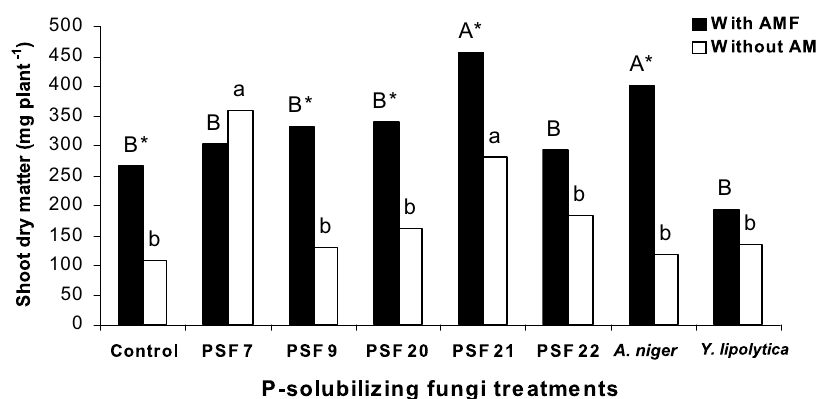
Fig. 1 – Shoot dry matter (two cuts) of clover inoculated with P-solubilizing fungi from Paraty, Rio de Janeiro, Brazil (PSF 7, 9, 20, 21 and 22) and from Granada, Spain ( A. niger and Y. lipolytica ), in the presence or absence of AMF. (Lower-case and upper-case letters compare PSF treatments in the absence and presence of AMF inoculation, respectively, by the Scott-Knott test ( p ≤ 0 . 05 ) . *: indicates AMF effect by the F test ( p ≤ 0 . 05 ) .